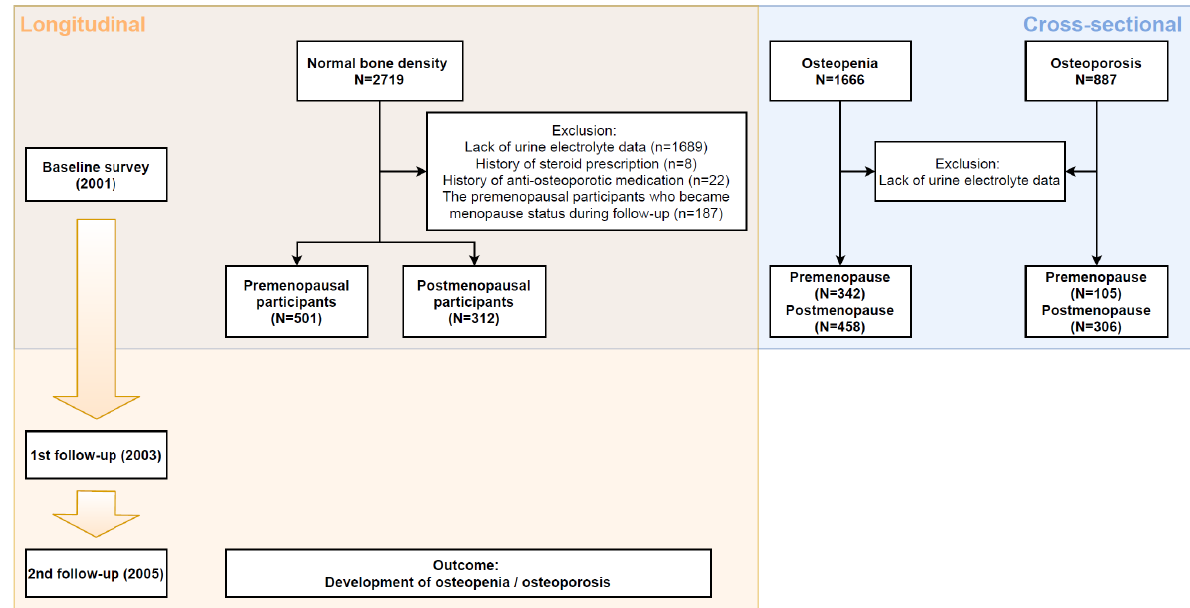
Figure 1. Study flow chart. Orange and blue squares represent longitudinal and cross-sectional study, respectively. The median ages of premenopausal and postmenopausal participants were 43 and 55 years, respectively. Most of the blood and urine electrolyte levels, along with medical histories, were significantly different across premenopausal and postmenopausal partici- pants. Postmenopausal participants had higher serum and urine calcium levels and higher levels of uricosuria and proteinuria (Table 1). Table 1. Baseline characteristics of premenopausal and postmenopausal participants.